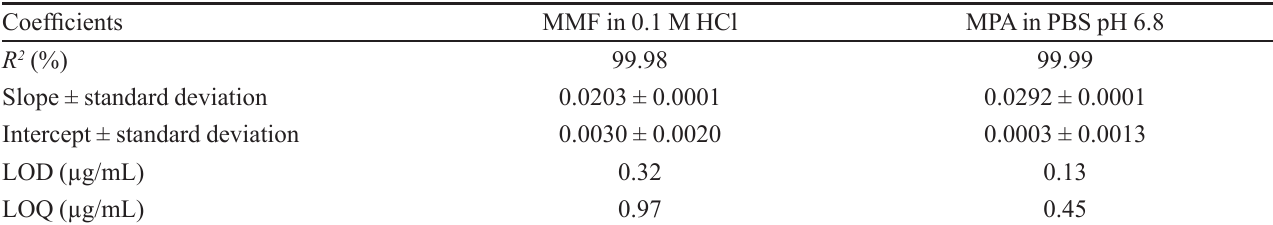
TABLE VI - Results of linearity, LOD and LOQ for MMF and MPA in selected media 0.1 M HCl and PBS pH 6.8, respectively, using UV method, λ 250